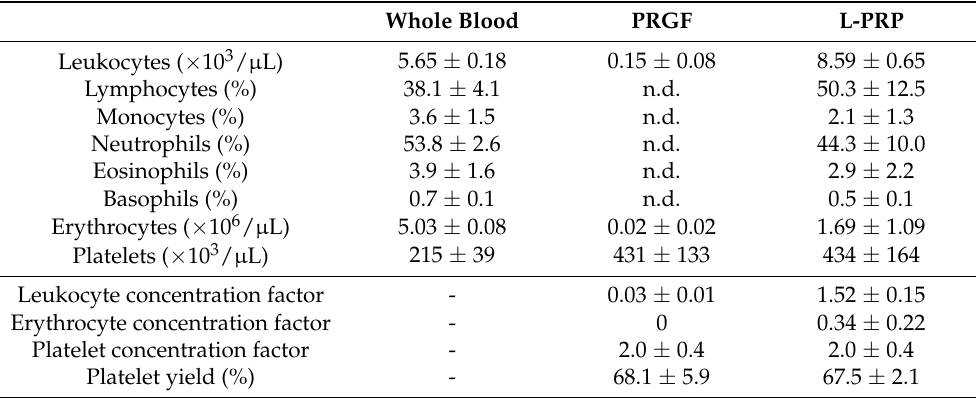
Table 1. Characterization of whole blood, PRGF and L-PRP samples included in this study. Leuko- cyte, platelet and erythrocyte concentrations were measured in whole blood and PRGF. Leukocyte, erythrocyte, and platelet concentration factors relative to the level of peripheral blood and platelet yield (%) are also indicated. Data are expressed as means ± SDs, n = 3 (biological replicates). n.d., not